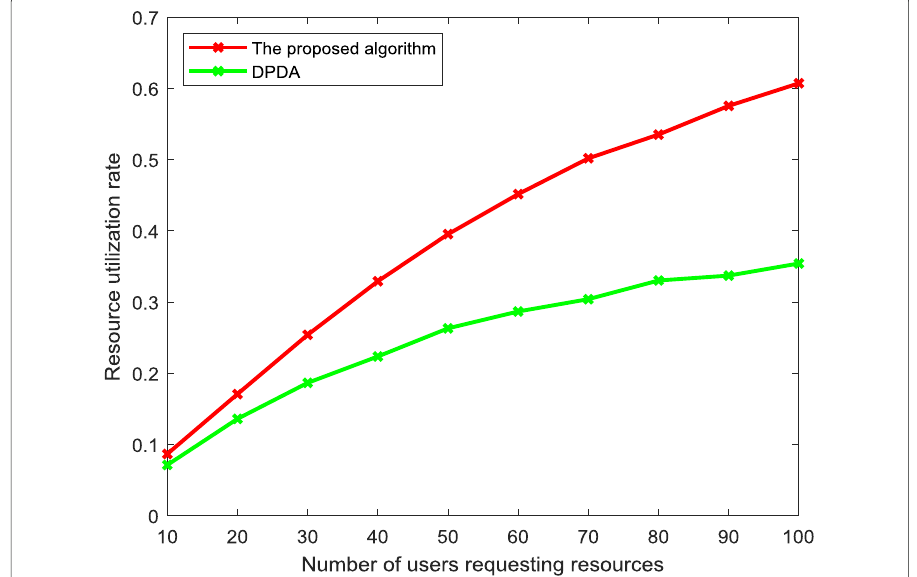
blockchain platform, and adopt the Solo ordering service to attain a consensus with 2MB block size to implement the payment mechanism. There are ten peers, one order peer, and a CA (Certificate Authority) in the environment as shown in Fig. 7. The peer represents the cloud and the order peer uses a Solo consensus protocol to produce a totally ordered sequence of endorsed transactions in blocks and broadcasts the blocks to the other